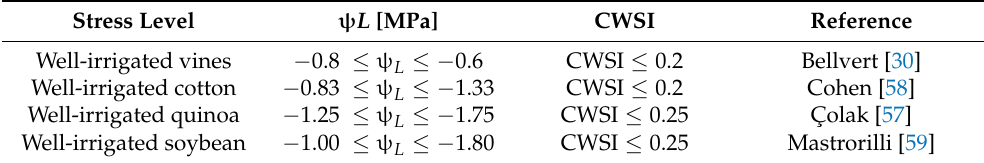
Table 3. Index values—adapted from Bellvert [28], Cohen [58], Çolak [57], and Mastrorilli [59]. Leaf water potential ( ψ L ) , CWSI (Crop Water Stress Index). Stress Level ψ L [MPa] CWSI Reference Well-irrigated vines Bellvert